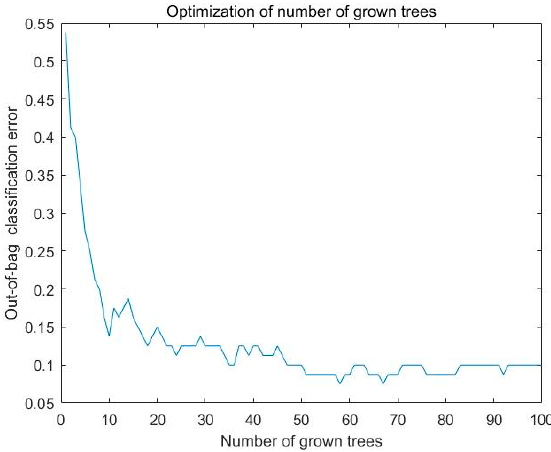
Figure 8. Optimization of the number of grown trees.